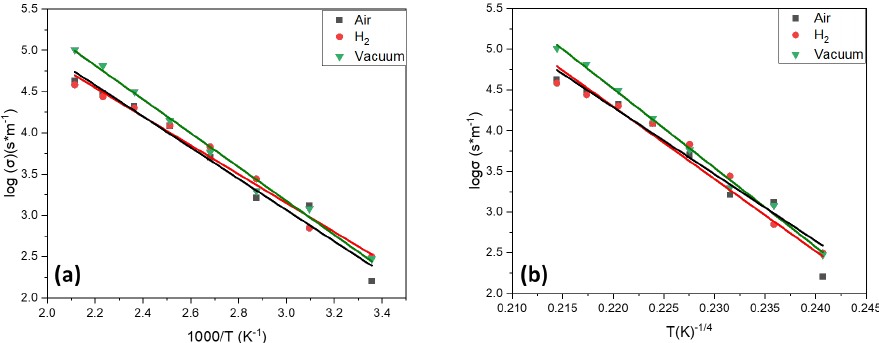
Figure 13. The Arrhenius plot of SnO 2 in dry air, a vacuum and a hydrogen environment as a function of ( a ) 1000/T and ( b ) 1/T 1/4 .